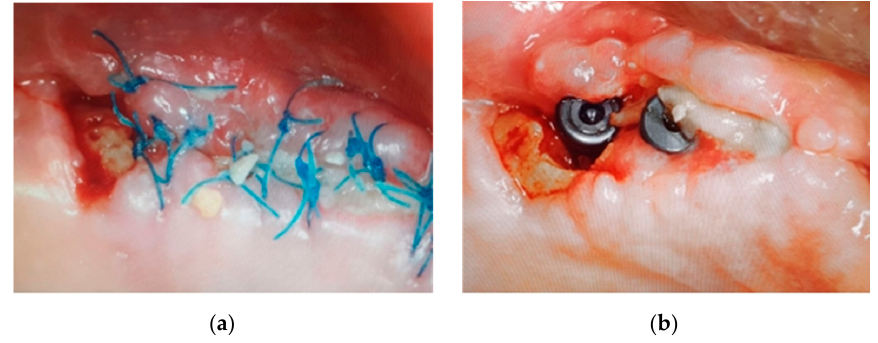
Figure 7. Bone exposure in the distal implant at 7 ( a ) and 15 ( b ) days post implant-surgery.